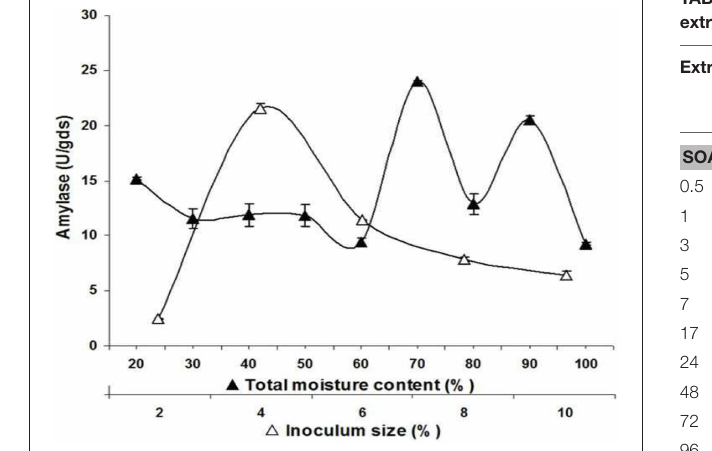
FIGURE 2 | Effect of initial moisture content and inoculum size on biosynthesis of extracellular amylase by A. terreus NCFT 4269.10 performed for 96 h at 30 ◦ C using solid state fermentation.